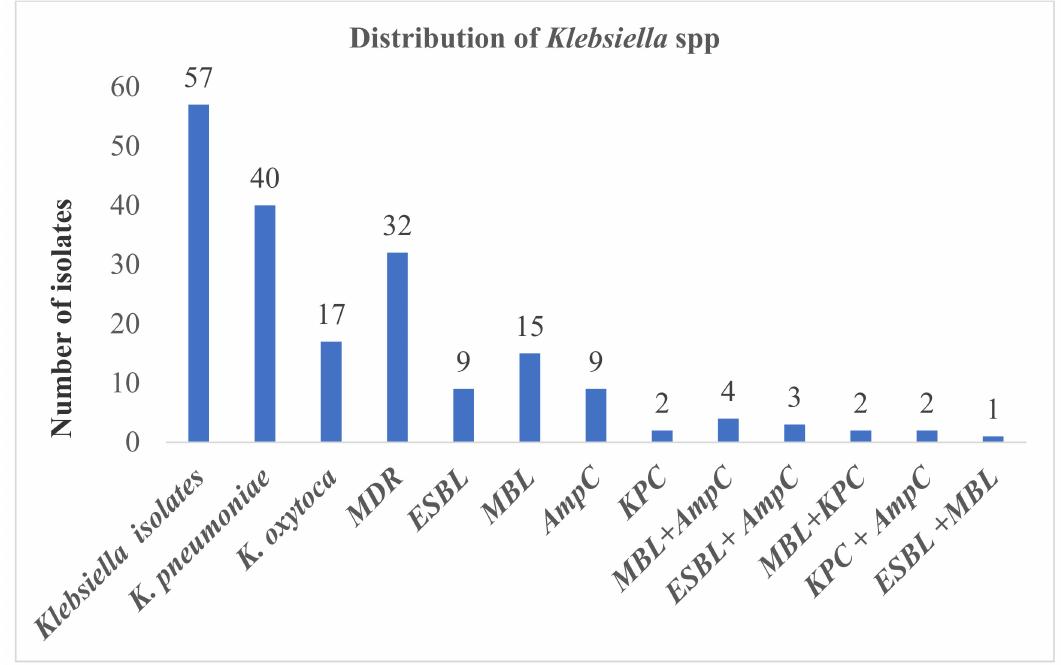
Figure 2. Distribution of ESBL, MBL, AmpC and KPC producing Klebsiella